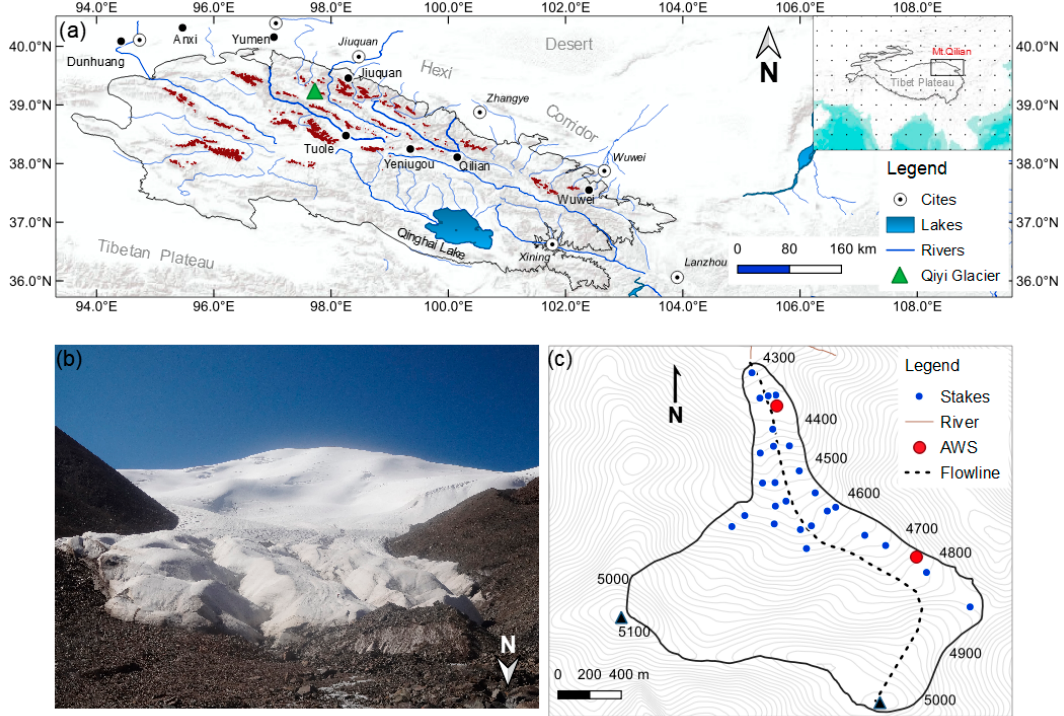
Figure 1. The location of the Qiyi glacier in the Qilian Mountain and the adjacent meteorological stations. ( a ) The glaciers (dark red) and the adjacent meteorological stations (black dots; Source: ESRI Basemap DigitalGlobe imagery), ( b ) the pictures of Qiyi glaciers, and ( c ) the stakes and AWSs on the Qiyi glacier.